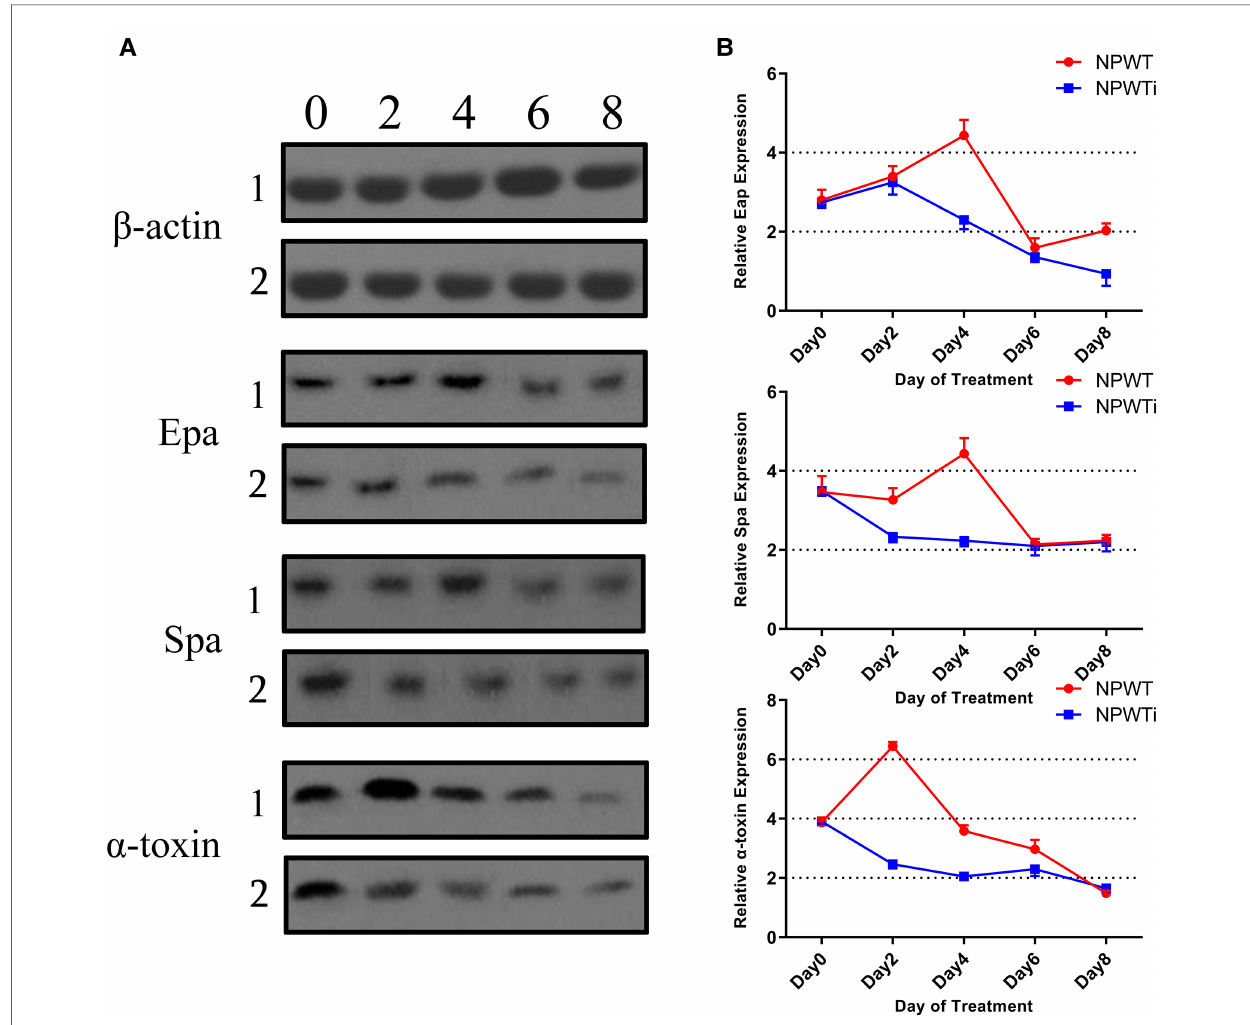
FIGURE 4 Differences in protein expression in the two treatment groups over time (fold